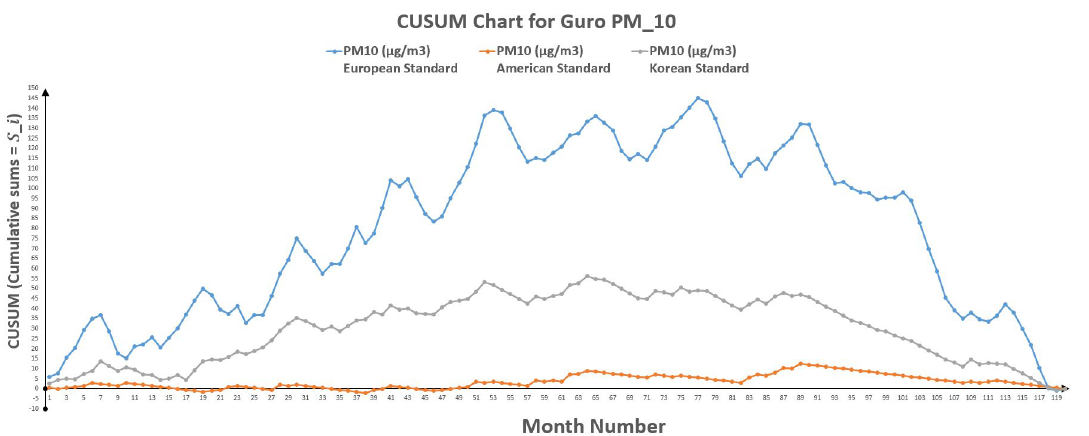
Figure 3. CUSUM chart for Guro PM 10